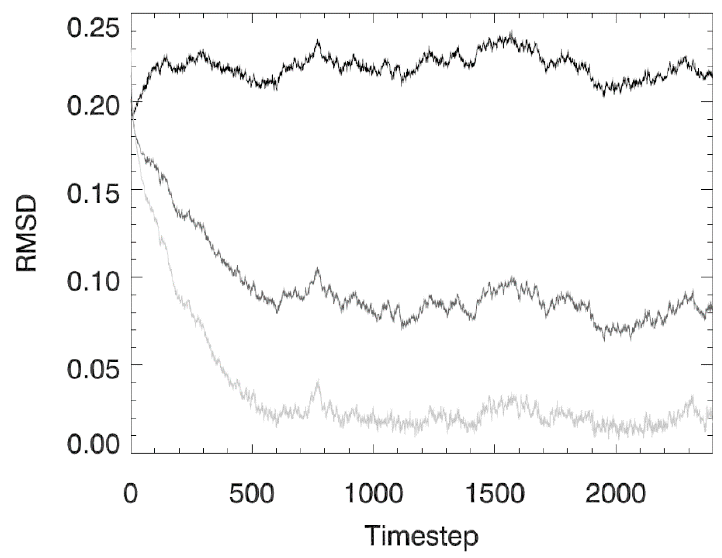
Figure 7. The time evolution of the root mean square difference (RMSD) between the cell averages and the analytical solution for the three cases presented in the Figure 3 (dark line for 5 cells, medium line for 10 cells, and light line for 20 cells).